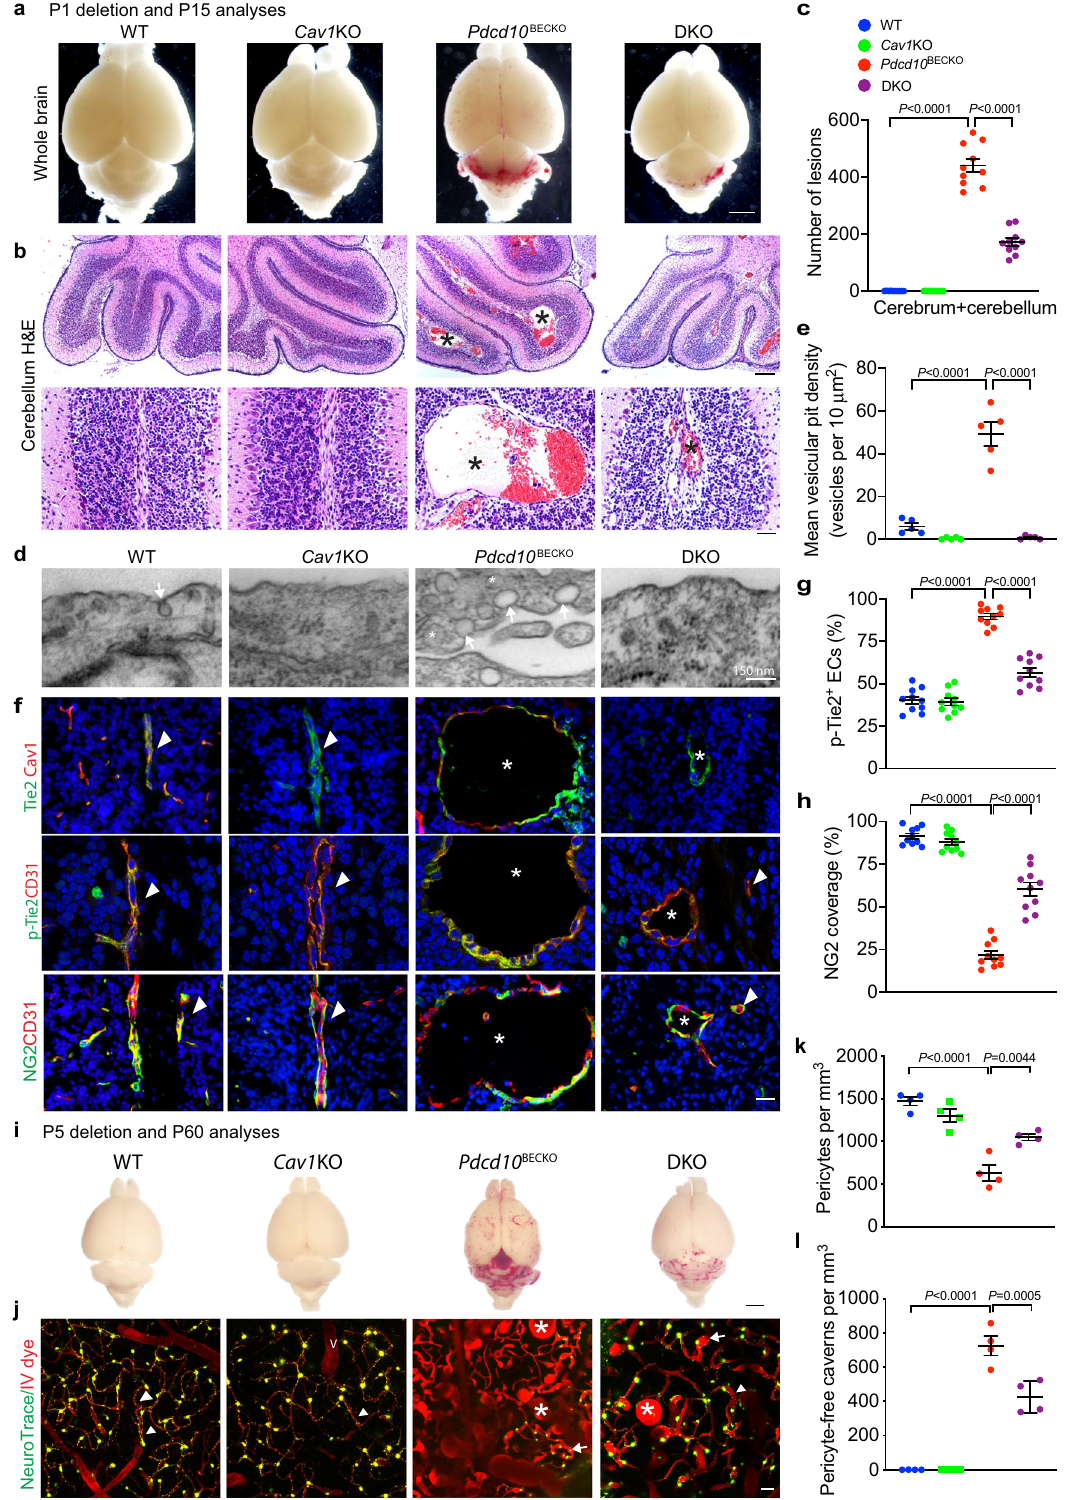
(STRIPAK) complex regulates Golgi stability and CDC42 or Rab11-dependent receptor endocytic recycling 62 . The STRIPAK complex was identi fi ed by proteomic analysis which revealed that CCM3 and GCK kinases together with PP2A were present in a striatin family-associated protein complex 63 . Interestingly, stria- tin family members in STRIPAK complex contain a caveolin scaffolding domain-interaction motif and have been shown to